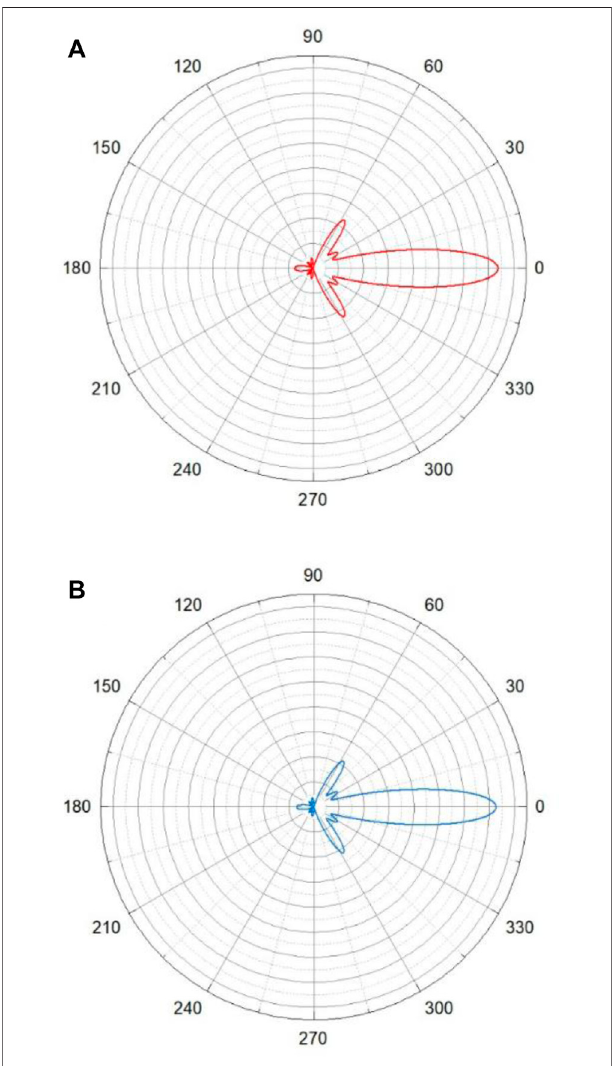
FIGURE7|(A) RCS(scale of0.1 m) ofacylinderplacedinexpander (B) RCS (scale of 0.1 m) of bare transformed cylinder.